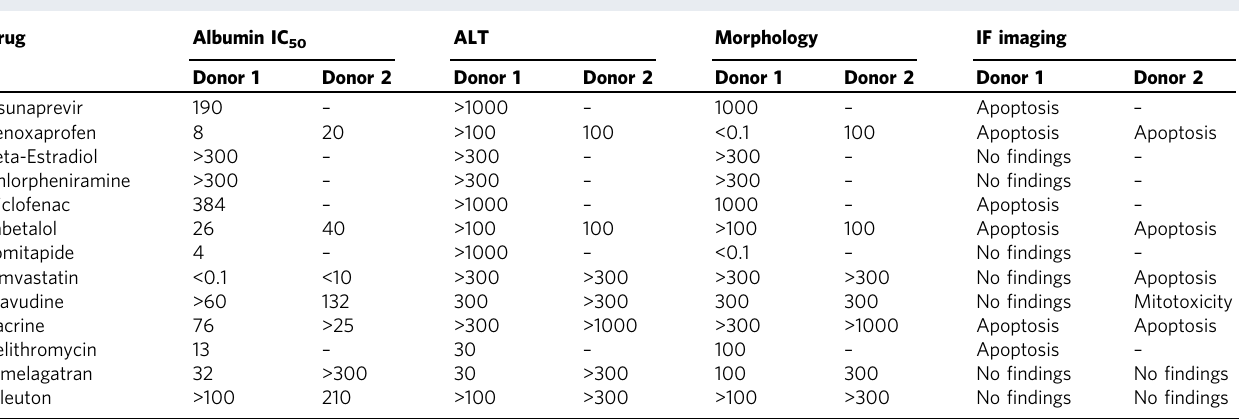
Table 3 Results obtained with the expanded drug